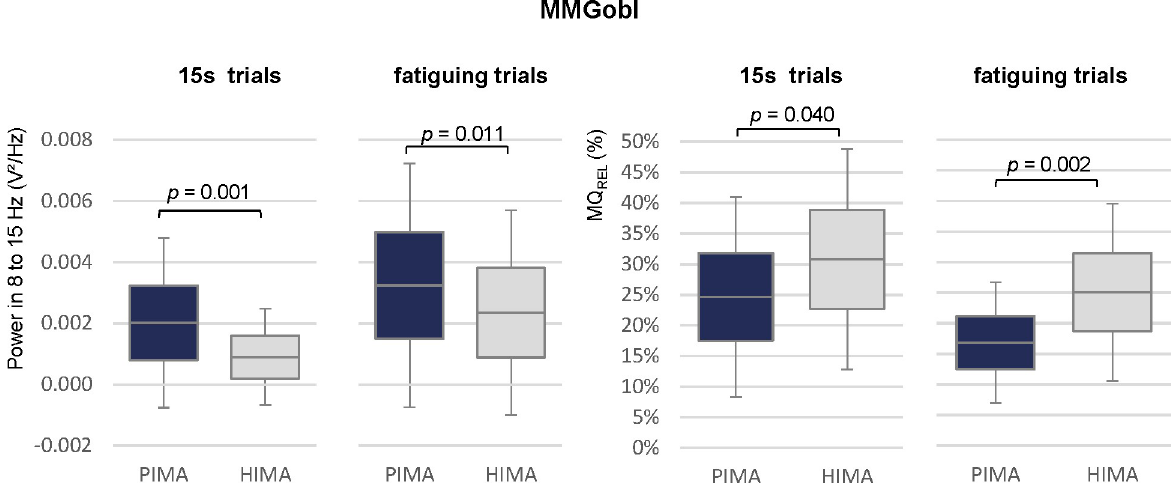
Fig 5. Power in 8 to 15 Hz and power frequency ratio MQ REL . Displayed are the arithmetic means, standard deviations (error bars) and the 95%- confidence intervals of the power in the frequency range of 8 to 15 Hz (left) and of the power frequency ratio MQ REL of the MMGobl signal during the 15s and fatiguing trials for the tasks PIMA (blue) and HIMA (grey). Statistical comparisons between PIMA and HIMA revealed significant results for all comparisons with p = 0.001 to 0.04 and effect sizes of r = 0.47 to